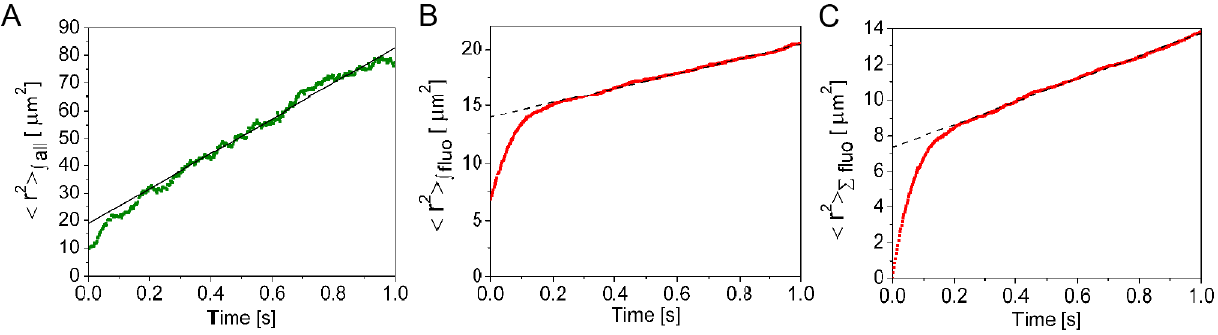
Figure 2. Second moments of particle distributions and mean square displacements obtained from a simulation of particles that diffuse and react with immobile binding sites. Similar to Fig. 1 but for the simulation of Video S2 which corresponds to a system of particles that diffuse with D f ~ 20 m m 2 = s and react with immobile binding sites according to Eq. (1). The simulation parameters are such that the effective diffusion coefficients defined in Eq. (2) are D coll ~ 10 : 18 m m 2 = s and D sm ~ 0 : 72 m m 2 = s . As in the simulation with the freely diffusing particles, the simulation starts when a bolus of fluorescent particles is added to a background of (non-fluorescent) particles that are initially spatially uniform and in chemical equilibrium with the binding sites. Also in this case we compute two second moments and the averaged mean square displacement of the (shown in gren) computed added particles to quantify relevant properties of the simulation. For more details see Materials and Methods. A : S r 2 T Ð all (shown in red) computed using Eq. (12) with n i using Eq. (12) with n i the number of all particles in the i th box. Linear fit (shown in black). B : S r 2 T Ð fluo the number of fluorescent particles in the i th box. Linear fit (shown in black). C : The mean of the squared displacements of the added particles (shown in red) computed using Eq. (11). Linear fit (shown in black). As explained in supplementary text 0.3, in this case, the diffusive behavior sets in after a transient. Once this behavior is reached, diffusion coefficients, D coll , D fluo and D sm , can also be estimated by taking 1/6 of the slope of the three fitting curves. Differently from the situation of freely diffusing particles, in this case, the estimates differ from one another. They yield A: D coll ~ 10 : 6 m m 2 = s ,